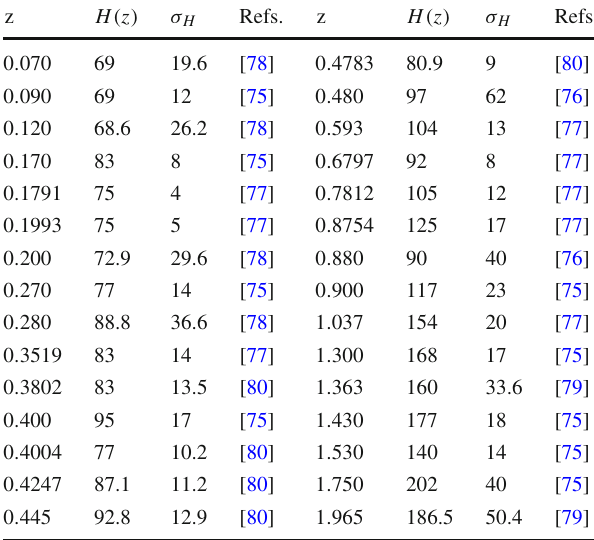
Table 2 Hubble parameter values H ( z ) with errors σ H from Refs.